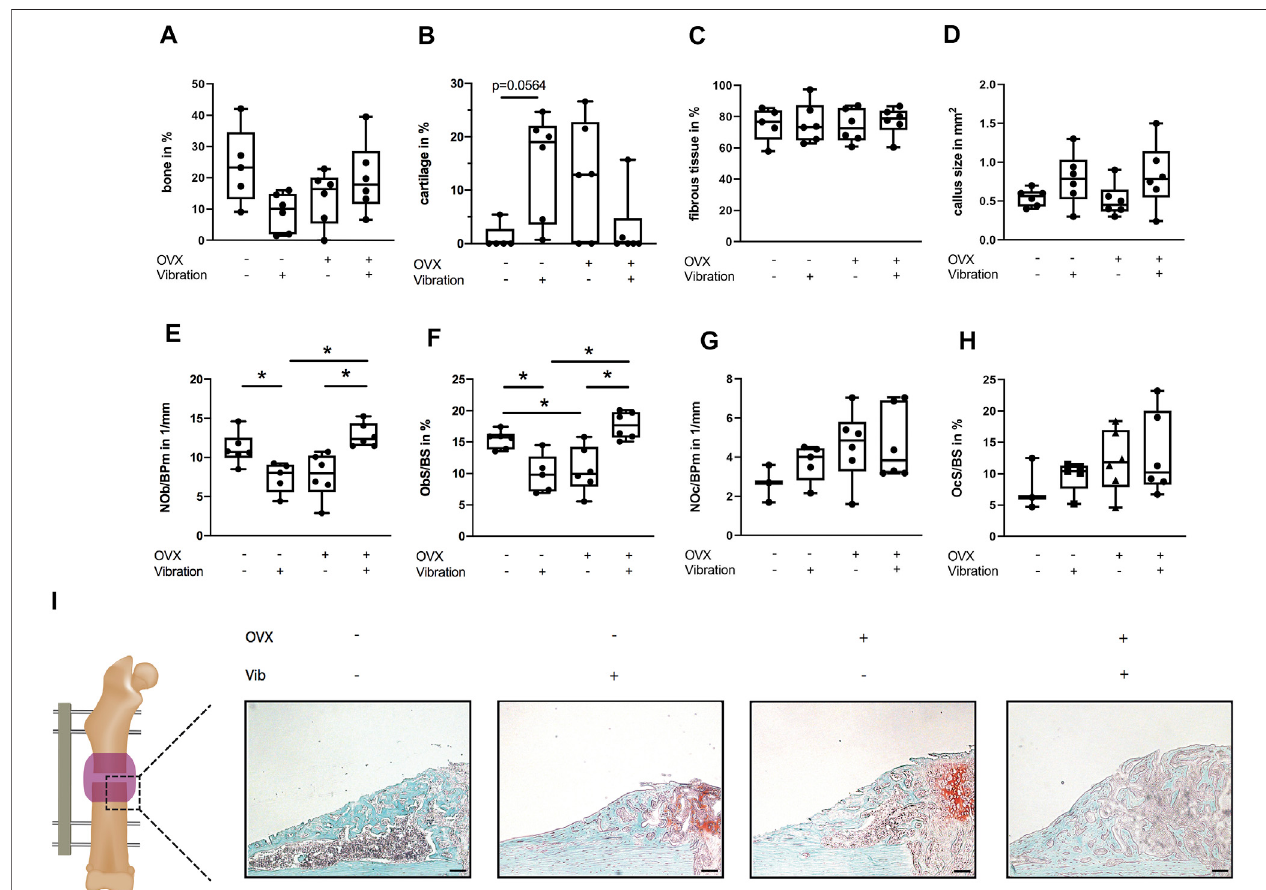
FIGURE 3 | Histomorphometrical analysis of the fracture gap in ER α fl / fl mice on day 21. Paraf fi n sections of fractured femurs were stained with Safranin O and histomorphometricalanalysiswasperformedtodetermine (A) relativebonearea, (B) relativecartilagearea, (C) relative fi broustissueareaand (D) callussize. (E) Number of − 6+s per bone perimeter (NOb/BPm) and (F) osteoblast surface per bone surface (ObS/BS) in the fracture gap. (G) Number of osteoclasts per bone perimeter (NOc/ BPm) and (H) osteoclast surface per bone surface (OcS/BS). (I) Representative images from the fracture callus at day 21 after surgery stained with Safranin O. Scale bar (cid:1) 100 μ m. Data are shown as box-and-whisker plots (with median and interquartile range) from max. to min., showing all data points. *indicates signi fi cant effects with p ≤ 0.05.